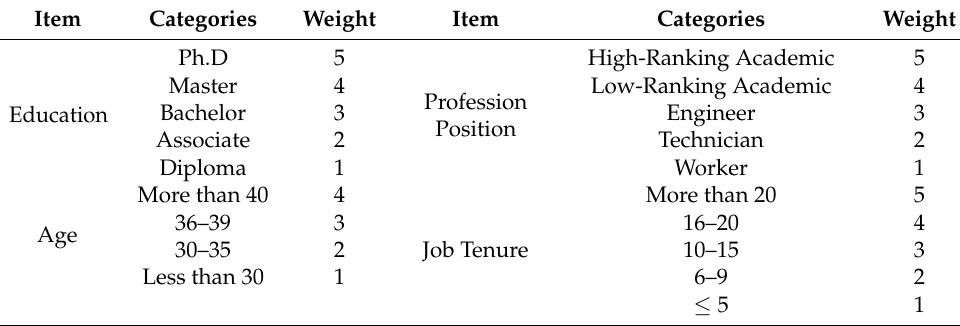
Table 1. Weight rating according to the experts’ attributes.